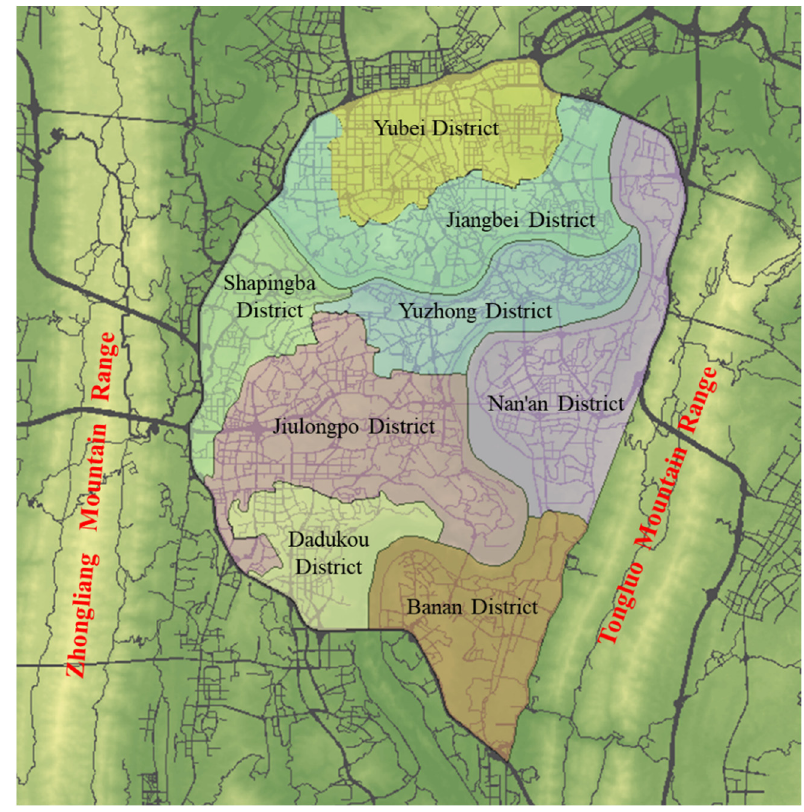
Figure 1. Research scope.